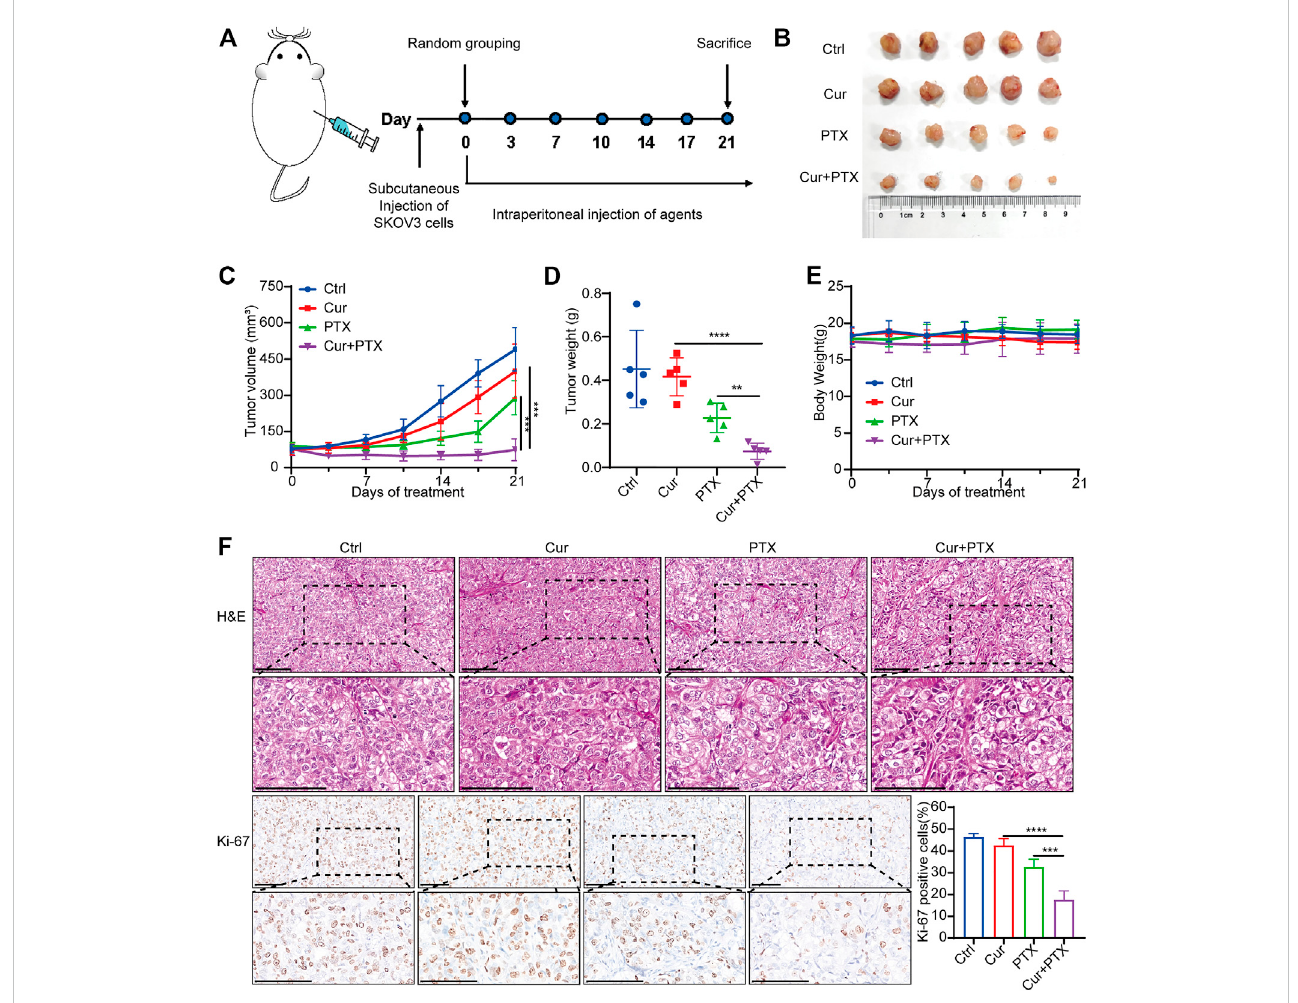
FIGURE 2 Cur and PTX synergistically suppress the tumor growth of SKOV3-derived xenograft models (A) Mice bearing SKOV3 xenografts were treated intraperitoneally with DMSO, Cur (20 mg/kg, B.I.W.), PTX (5 mg/kg/, B.I.W), or the combination of both agents as indicated ( n = 5 mice per group). (B) Images oftumors collected from mice treated with DMSO, Cur, PTX or thecombined agents. (C,D) Tumor volume and weight inthe xenografts treated with different agents. (E) Mice weight growth curves after indicated treatments at different time points. (F) Representative images of H&E staining and IHC staining of Ki67forxenografttumortissuesafterindicatedtreatments.Boxedregionsweremagni fi edandpresentedundertherespectivepanels.Scalebar,100 μ m.Data are presented as the mean ± SD from fi ve independent repeats. * p < .05, ** p < .01, *** p < .001, **** p <